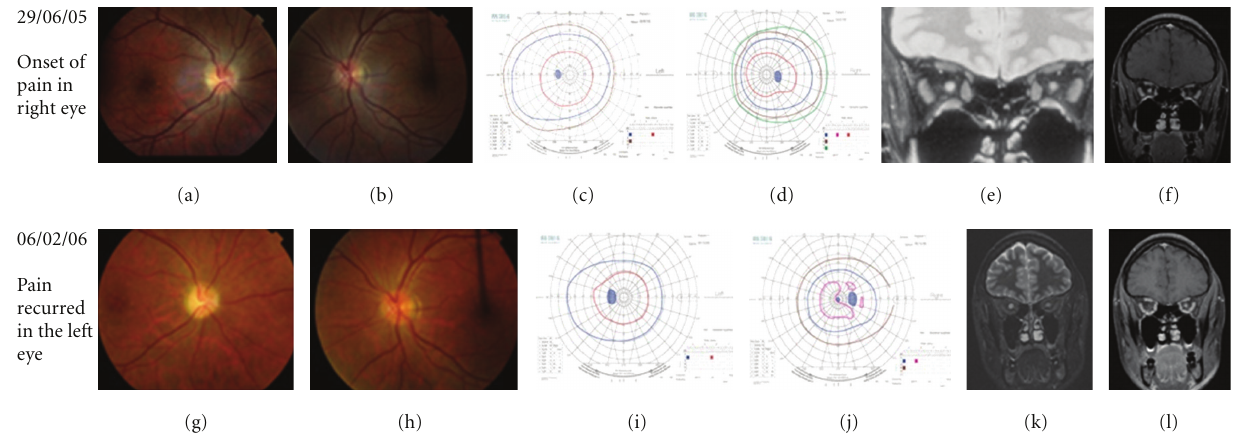
Figure 1: Disc photographs, Goldmann visual fields, and MR images of patient 1. (a)–(f) represent the initial episode in the right eye and (g)–(l) represent the recurrence in the left eye. Figure (e) is a coronal STIR image showing high signal within the right optic nerve, and Figure (f) is a coronal T1 fat saturation postgadolinium image showing associated optic nerve enhancement. (k) and (l) are coronal STIR and T1 postgadolinium images showing left optic nerve swelling and